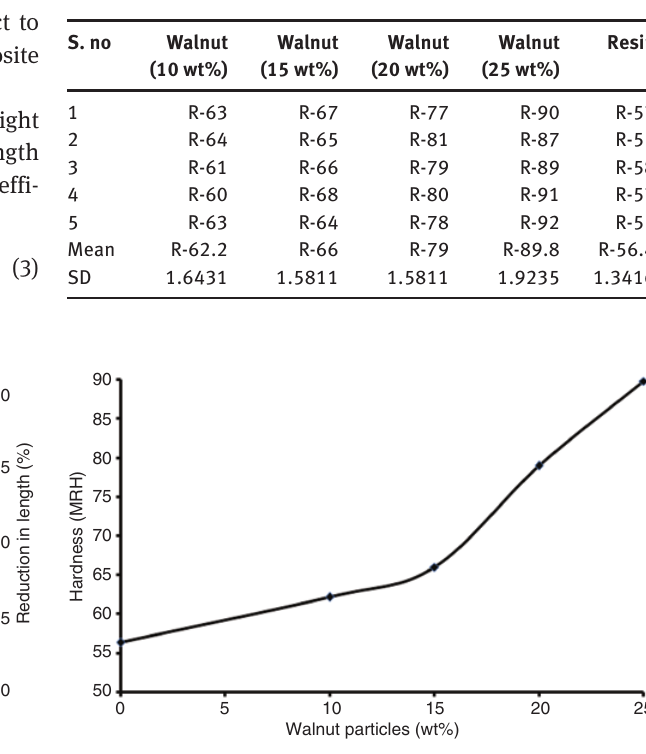
Figure 5 Ultimate strength for different weight percentage of walnut reinforced